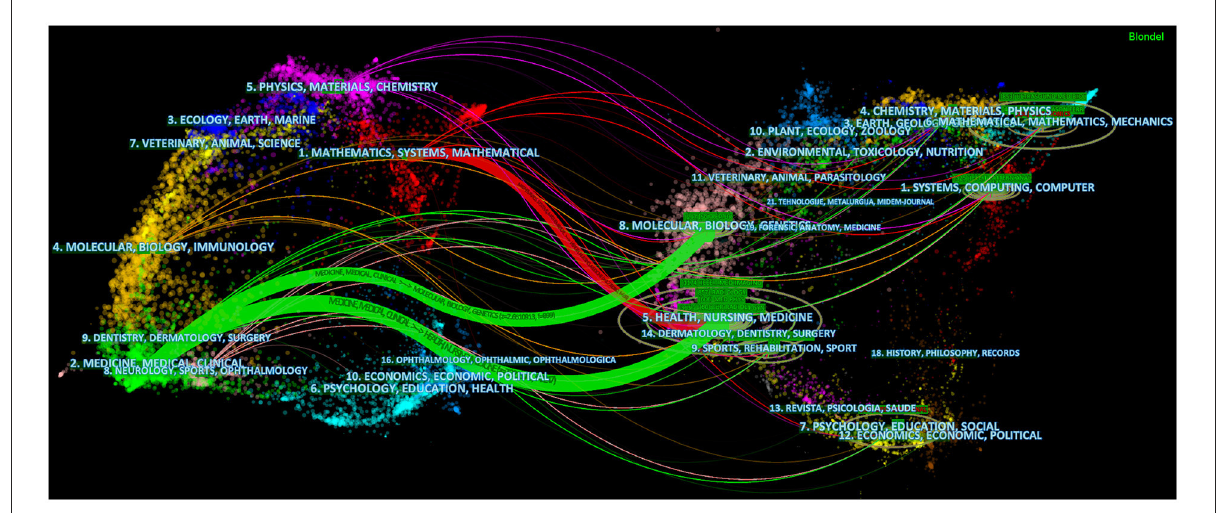
FIGURE7 Dual-mapping overlay about AI applied in the field of ultrasound. The left side represents the fields of articles included in the study, and the right side represents the fields of references of